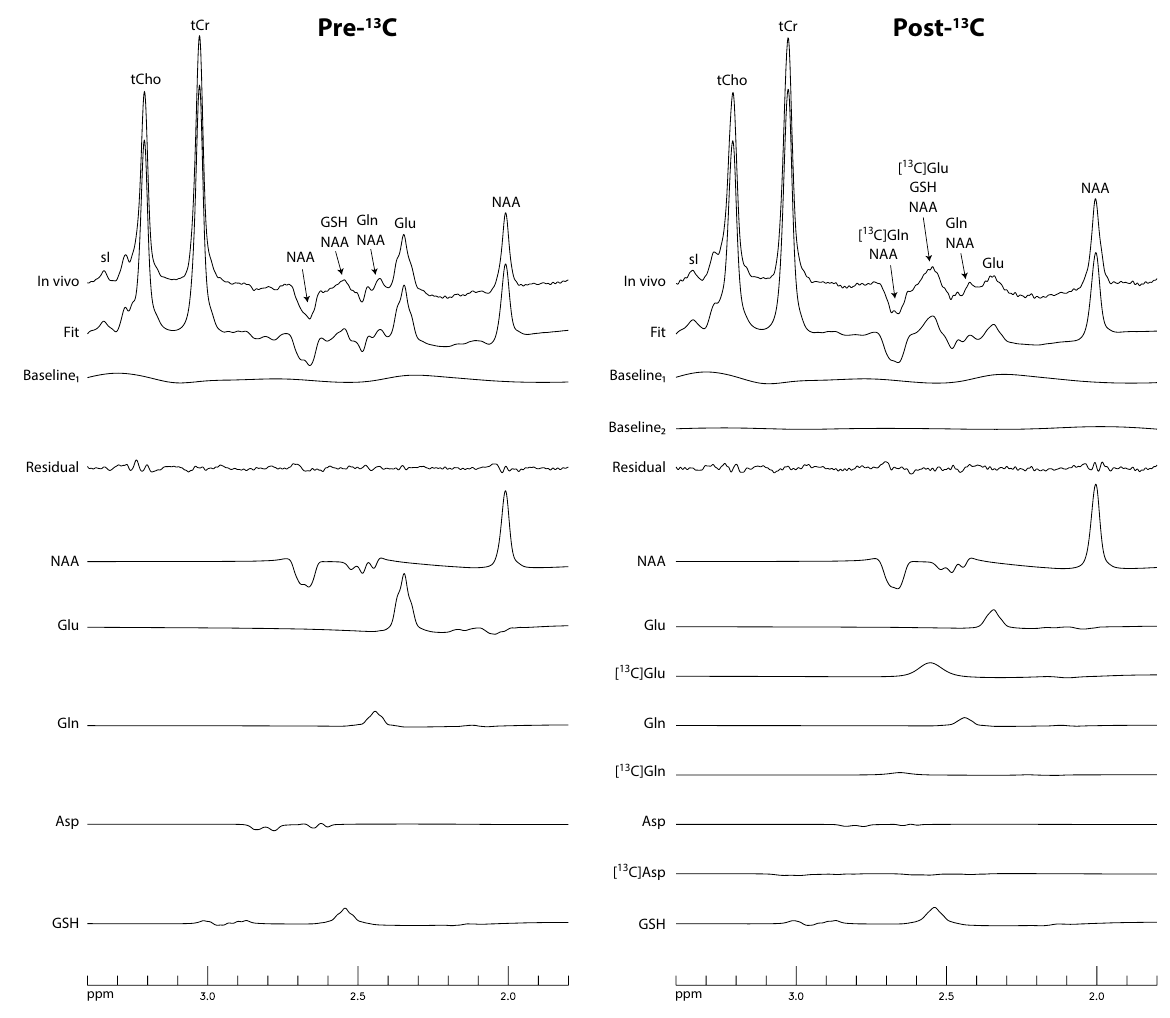
Figure 4. In vivo spectra and corresponding fitted spectra for the pre- 13 C MRS scan and the last post- 13 C scan of the participant in Fig. 3. Baseline 1 is the baseline in the pre- 13 C spectrum, which is a spline baseline with 13 knots. The baseline in the post- 13 C spectrum is baseline 1 + baseline 2 , in which baseline 2 is a much weaker spline baseline with 8